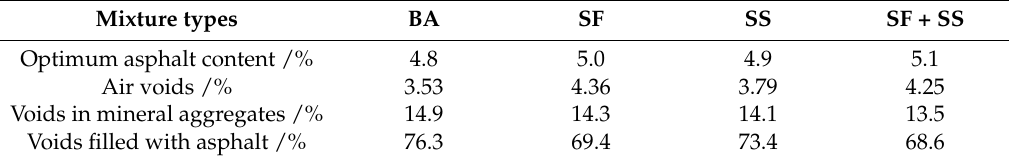
Figure 1. Gradation curves of basalt asphalt (BA) and steel slag (SS) mixture. Table 2. Compaction levels and mix design parameters. BA: basalt asphalt; SF: steel fibers; SS: steel slag.